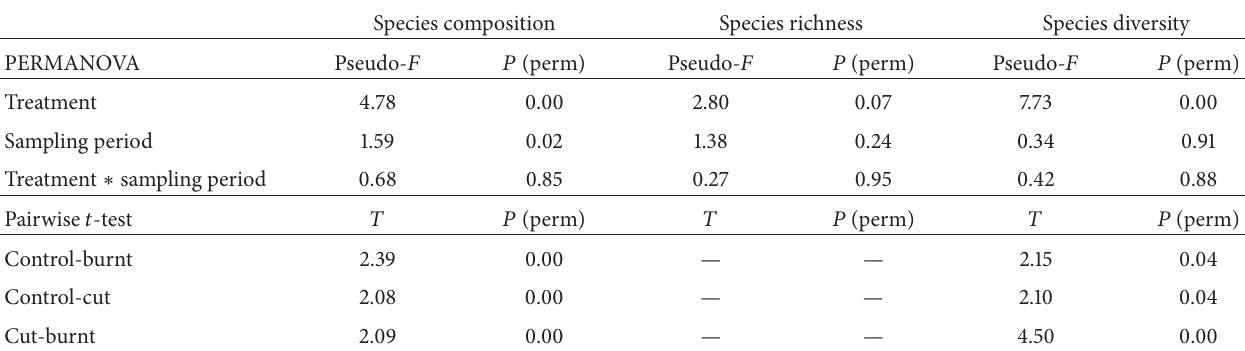
Table 1: Cutting and burning effects on vegetation in Pinus canariensis forest stand (Gran Canaria, Canary Islands). Summary of permutational-repeated measures MANOVA fitted for species composition, richness, and diversity. Results from pairwise t -test for sampling period are not included since they just display differences in species composition between sampling seasons (spring versus